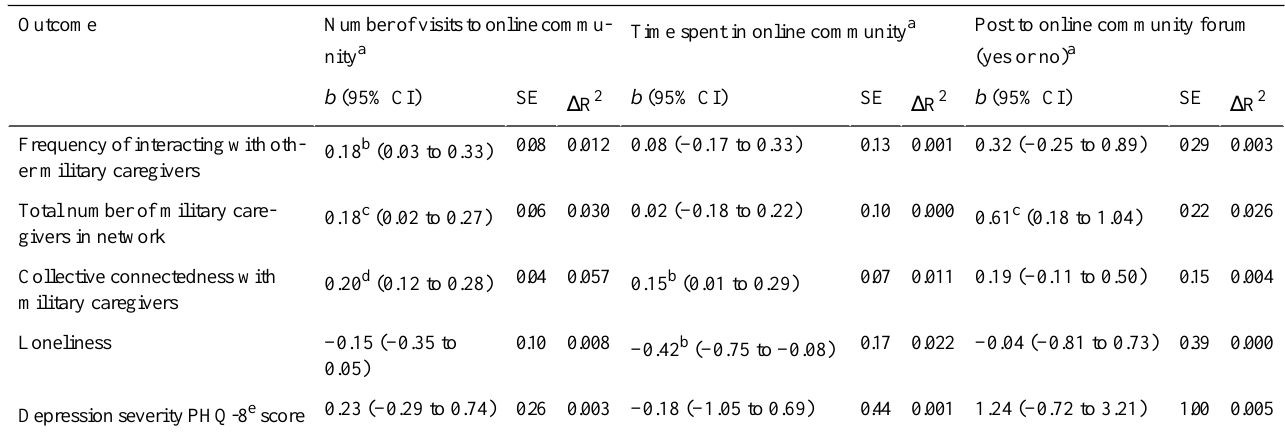
Table 3. Regression results predicting baseline to 6-month changes by 3-month engagement with online community